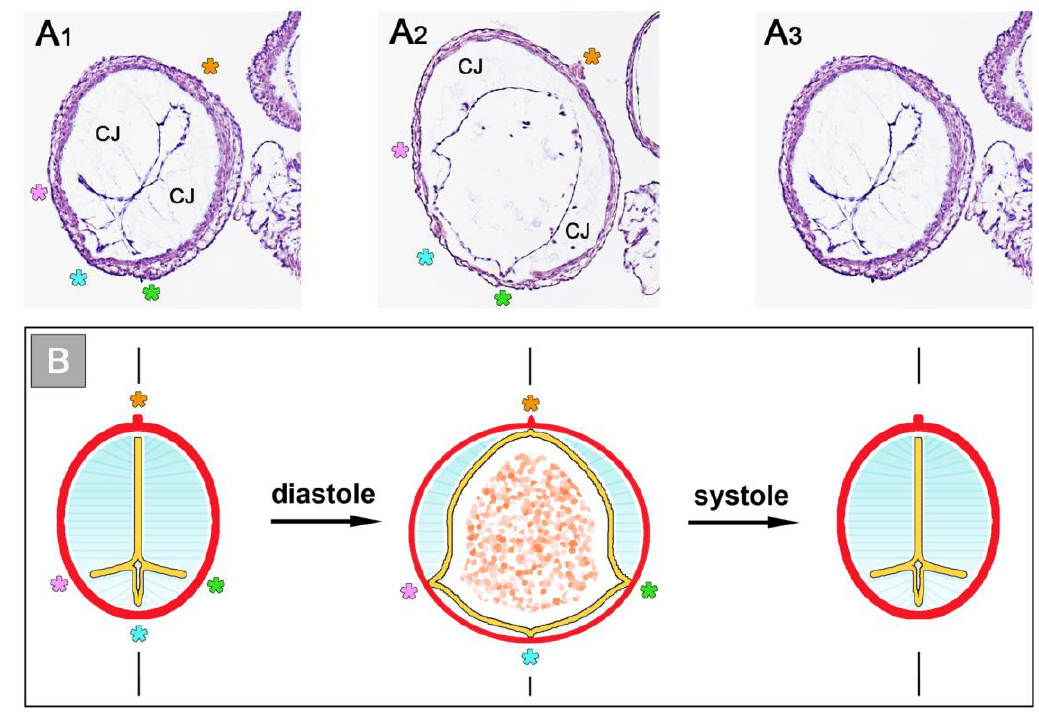
Figure 11. Initial phase of ventricular tube remodeling. Cardiac cycle-related changes in the cross-sectional shape of the ventricular bend as illustrated ( A ) by histological sections of HH-stage 16 chick embryonic hearts, which have been fixed in emptied ( A 1 ,A 3 ) and filled (A 2 ) states; and shown ( B ) by schematic drawings (same color code as used in Figure 2). Asterisks mark the original ventral (light blue) and dorsal (orange) midlines of the heart as well as the lateral borders of the trabecular shields (magenta and green). Note that, due to the formation of the trabecular shield, the opened endocardial tube has a bell-shaped or deltoid cross section, while the cross section of the collapsed endocardial tube has the shape of a Latin cross. Note also the cyclic changes in the thickness of the CJ layer.